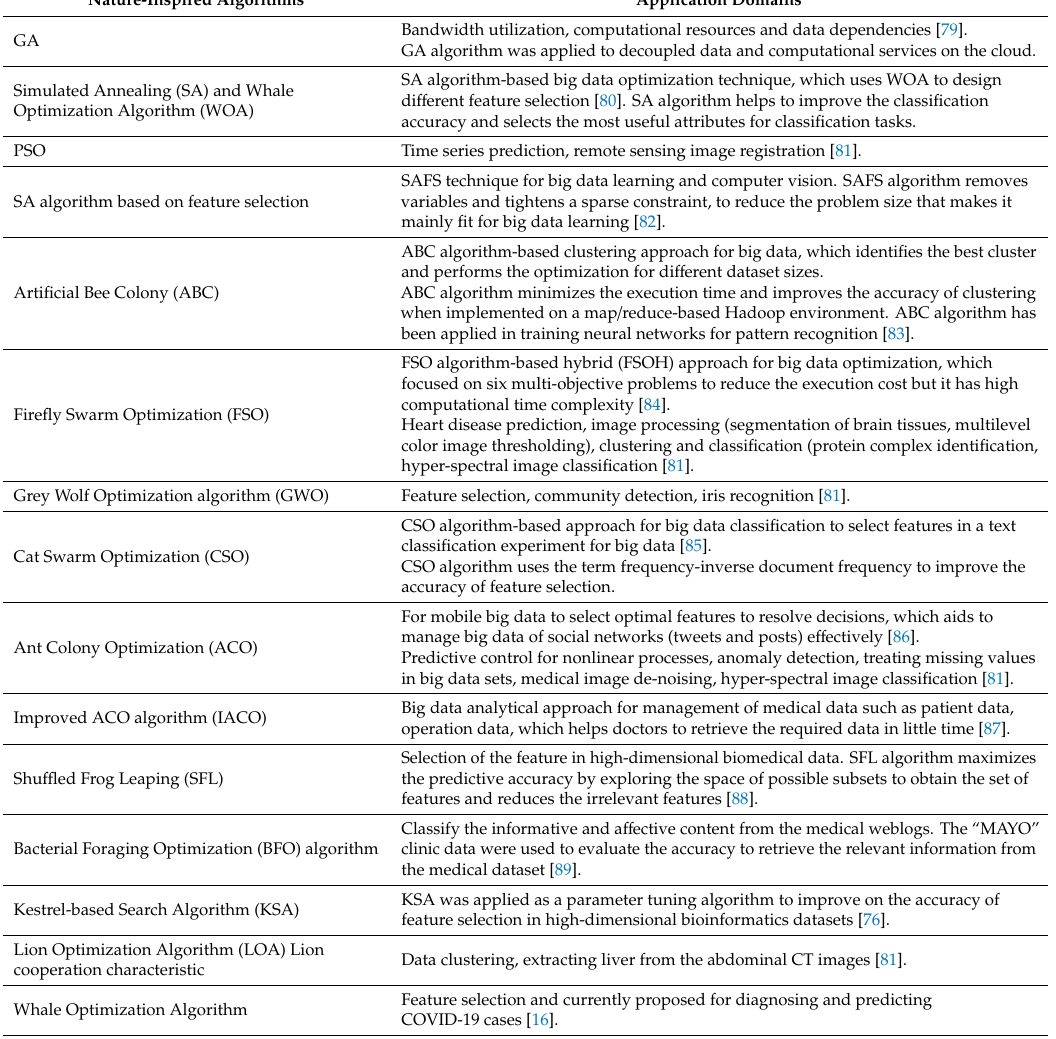
Table 3. Summary of nature-inspired